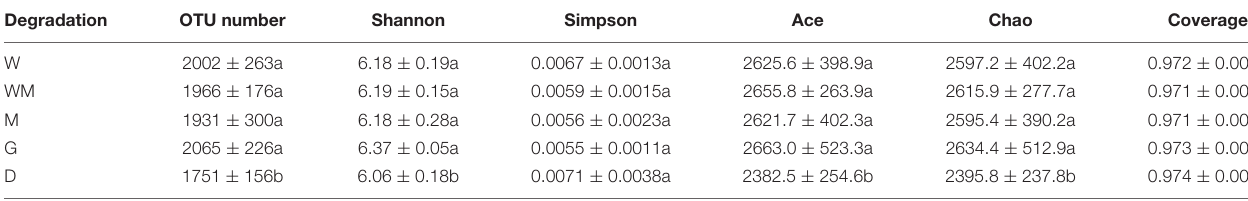
TABLE 2 | Microbial richness and diversity indices for clustering at 97% identity in soils along wetland degradation gradients. Degradation OTU number Shannon Simpson Ace Chao Coverage